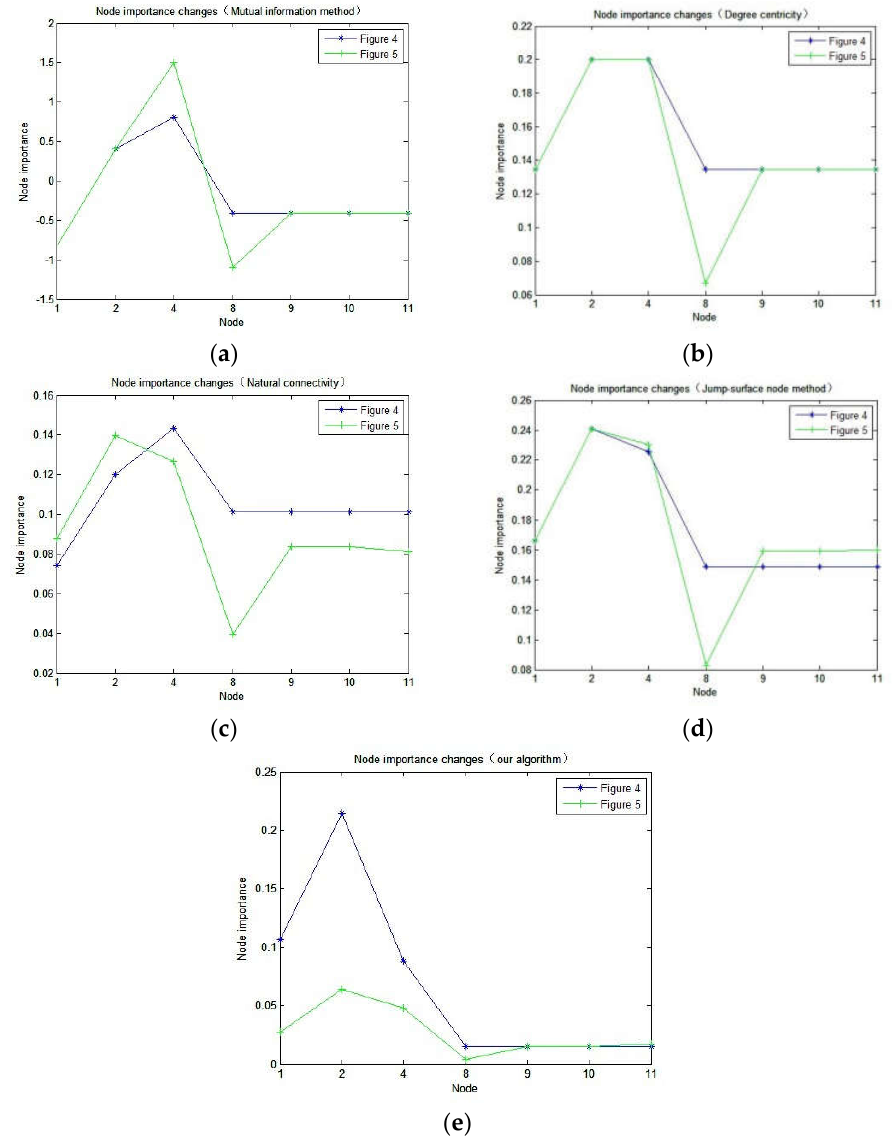
Figure 7. Comparison of node importance: ( a ) Mutual information method; ( b ) Degree centrality; ( c ) Natural connectivity; ( d ) Jump-surface node method; ( e ) Our method.